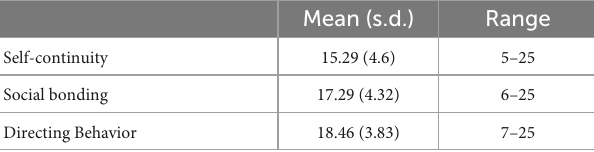
TABLE 5 Spanish TALE performance n =